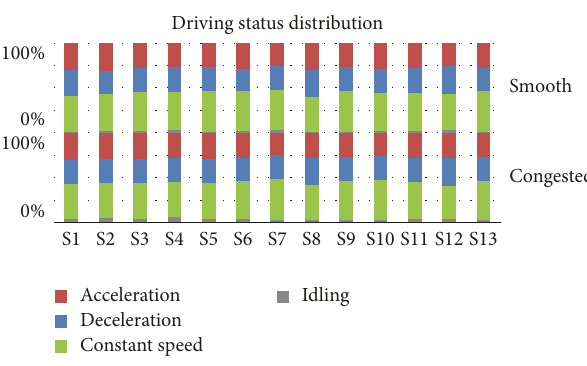
Figure 5: Driving status distribution for all drivers. Table 1: Mann–Whitney test for episode frequency by driving status according to traffic condition (congested versus